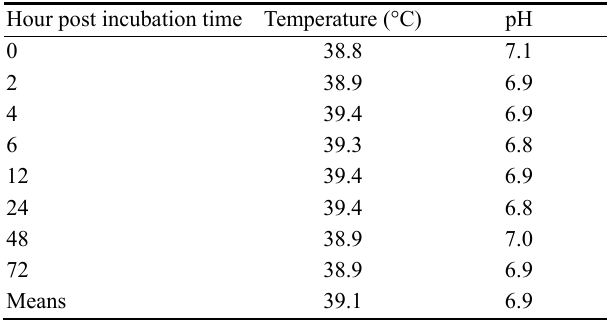
Table 3. Ruminal pH and temperature of crossbred beef